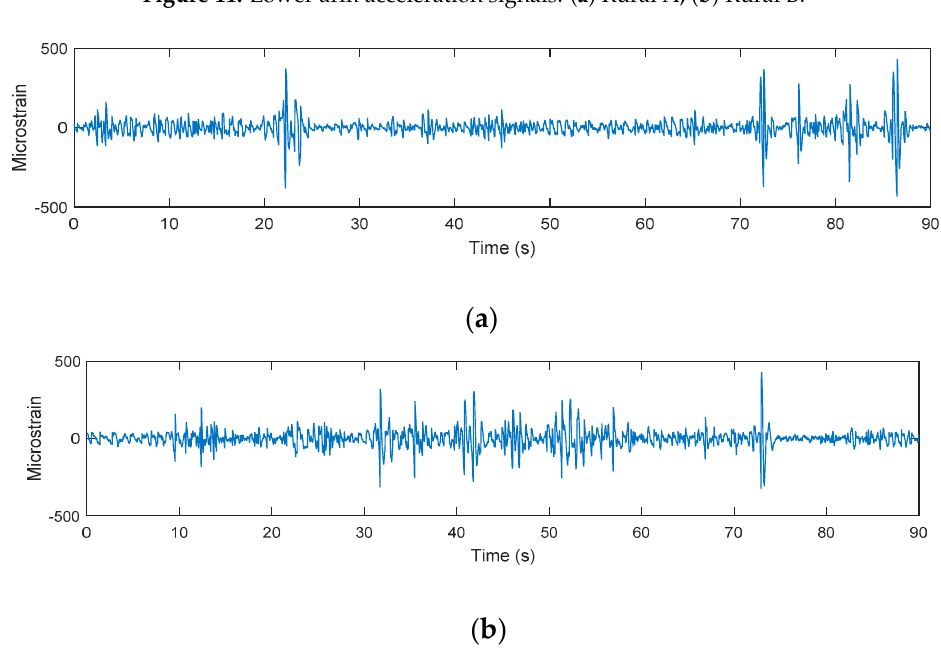
Figure 11. Lower arm acceleration signals: ( a ) Rural A, ( b ) Rural B.